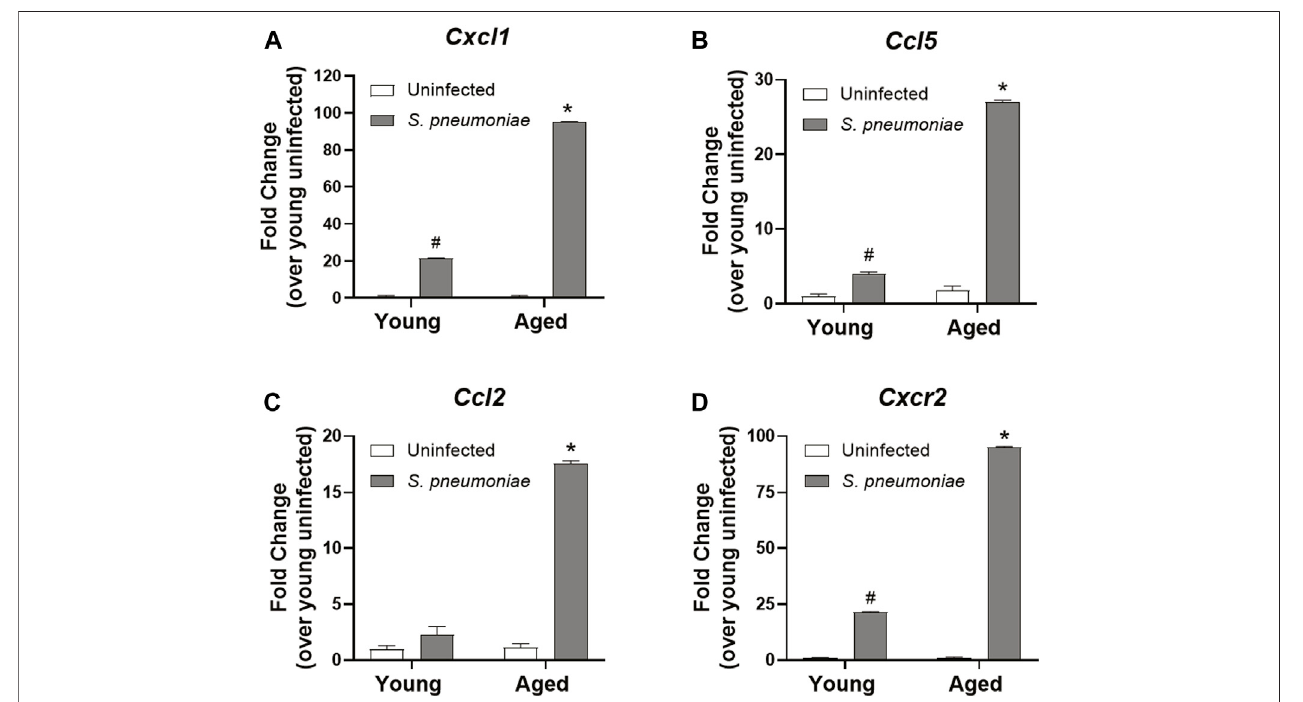
FIGURE 3 | Lung neutrophils from aged mice have increased chemokine expression following S. pneumoniae infection compared to young mice. qRT-PCR for Cxcl1 (A) , Ccl5 (B) , Ccl2 (C) and Cxcr2 (D) in neutrophils isolated from the lungs of young and aged uninfected or S. pneumoniae -infected mice. Data are presented as mean fold change over young uninfected lung neutrophils and signi fi cant changes were determined by ANOVA. * p < 0.05 compared to all other groups. # p < 0.05 compared to uninfected groups only. n = 3-6 mice per